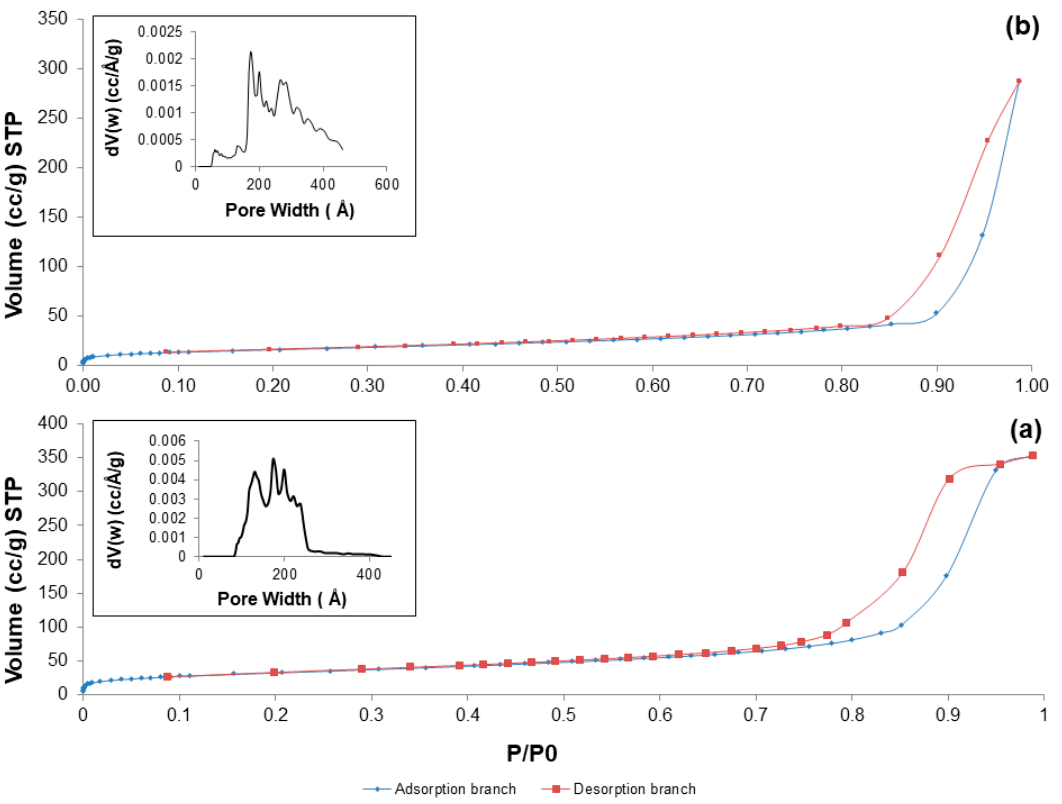
Figure 7. Nitrogen adsorption-esorption isotherms at − 196 ◦ C of: ( a ) 60S40C-air; and ( b ) 60S38C2Fe-air. Inset in both pictures reports the pore size distribution assessed by NLDFT method.